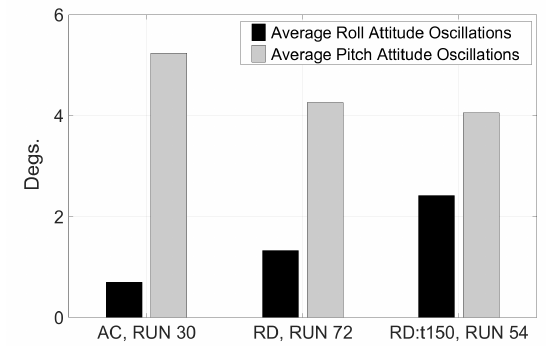
Figure 20. Pitch and roll axis oscillatory response, hover, 30 s stabilization period.